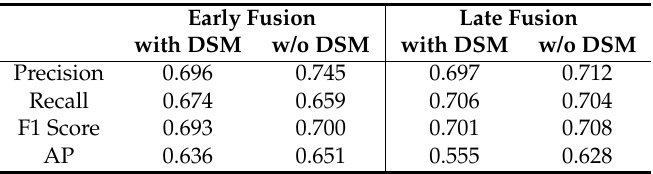
Table 2. Parking car detection results on the Barcelona test